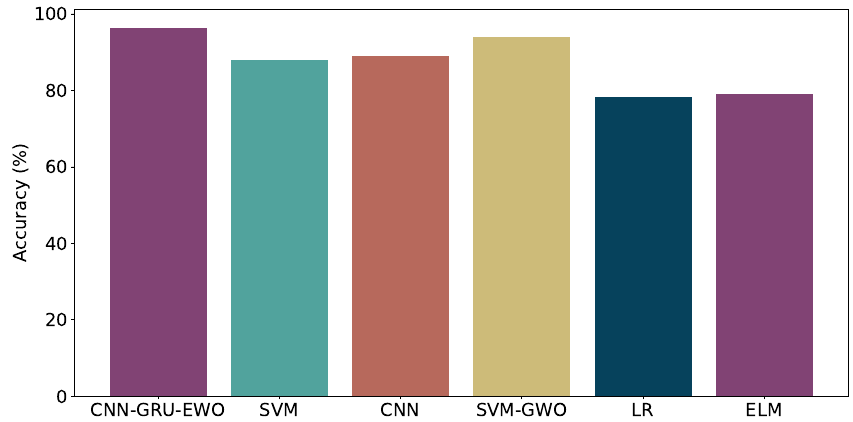
Figure 16. Accuracy of proposed techniques vs the State-Of-The-Art (SOTA).